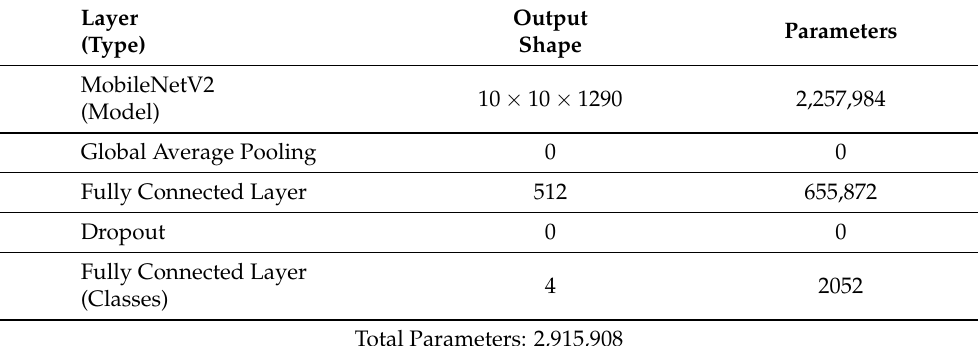
Figure 2. Modified MobileNetV2 architecture for multiclass classification problem (COVID-19, normal, viral pneumonia and lung opacity). Table 2. Details of the proposed architecture, parameters and output